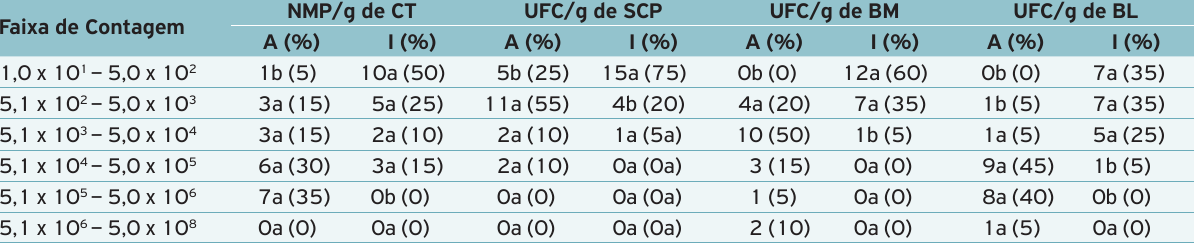
Tabela 1. Contagem de coliformes termotolerantes, Staphylococcus coagulase positiva, bactérias mesófilas aeróbias estritas e facultativas viáveis e bolores e leveduras nas amostras de linguiça tipo frescal, produzidas artesanalmente e inspecionadas, comercializadas no oeste do Paraná durante o período de abril a setembro de 2009. Faixa de